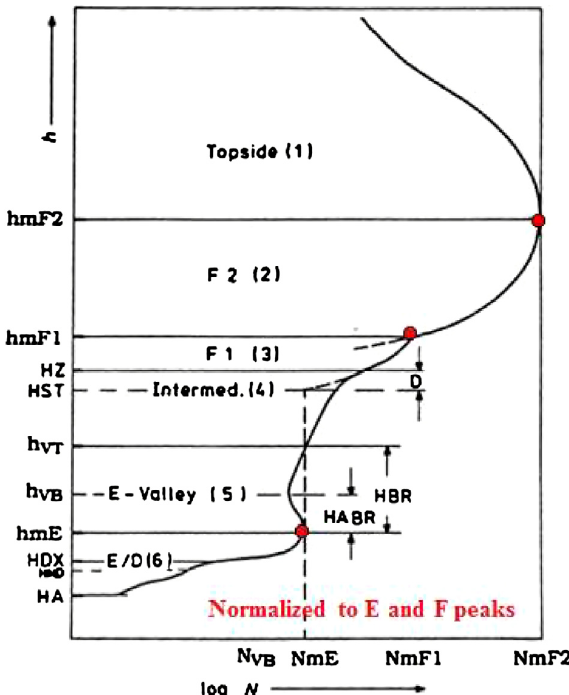
Fig. 2. Buildup of the IRI electron density profile and its separation into different